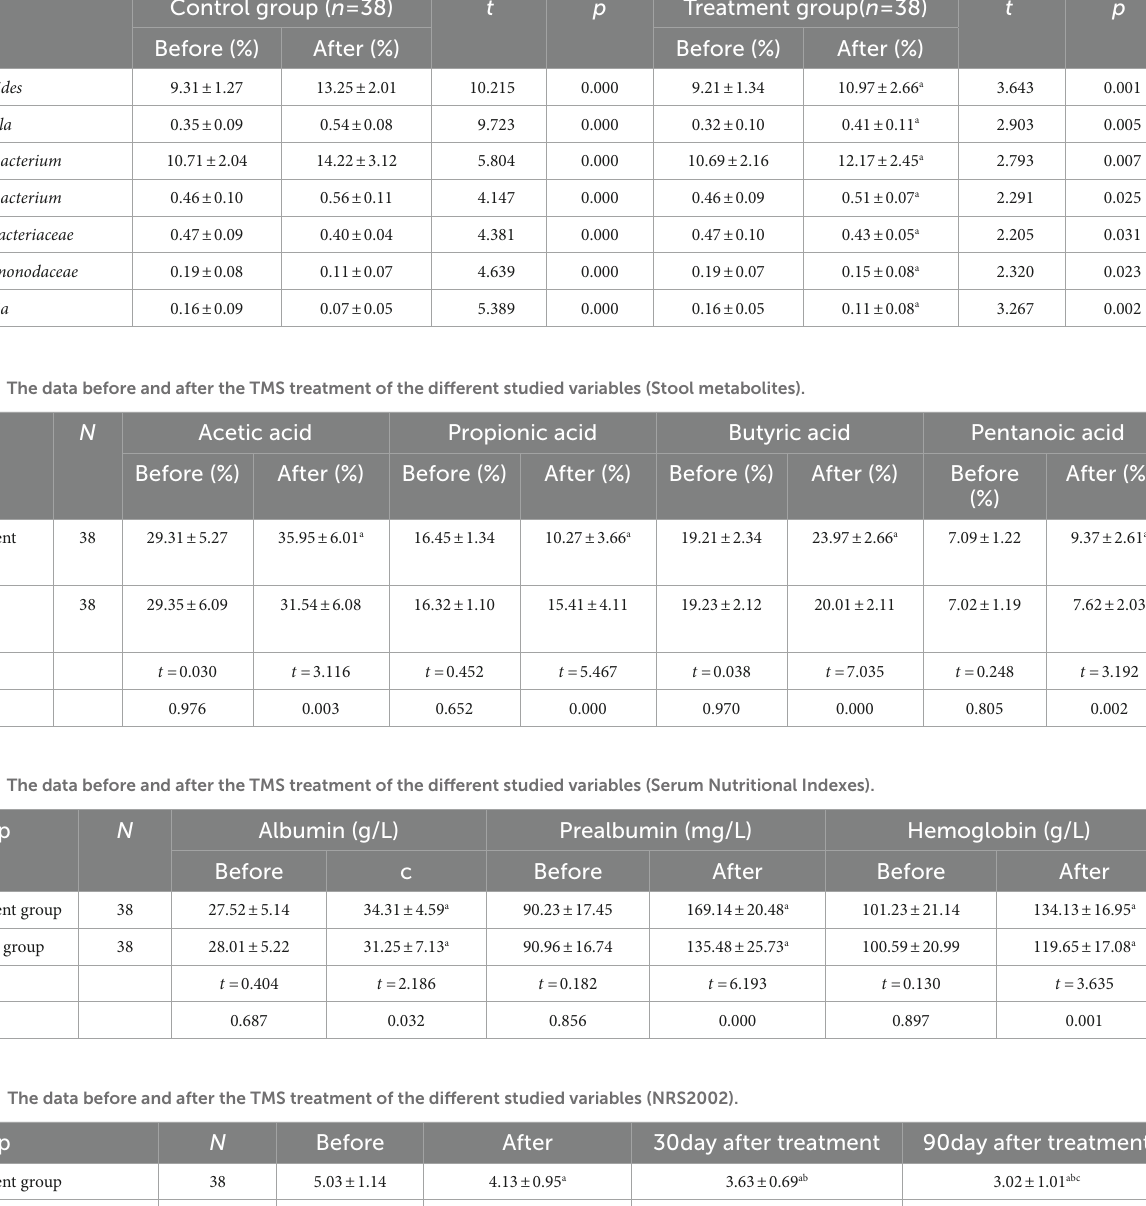
TABLE 1 The data before and after the TMS treatment of the different studied variables (Intestinal flora). Flora